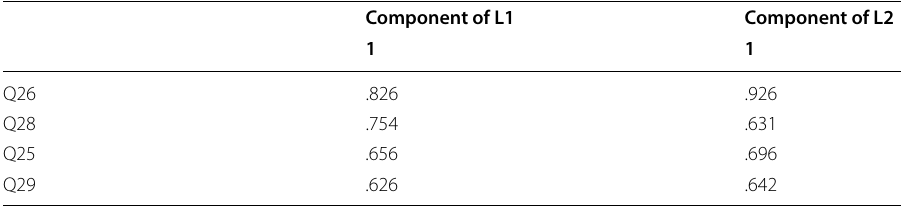
Table 15 Component Matrix for L1 and L2 Use in Assessment